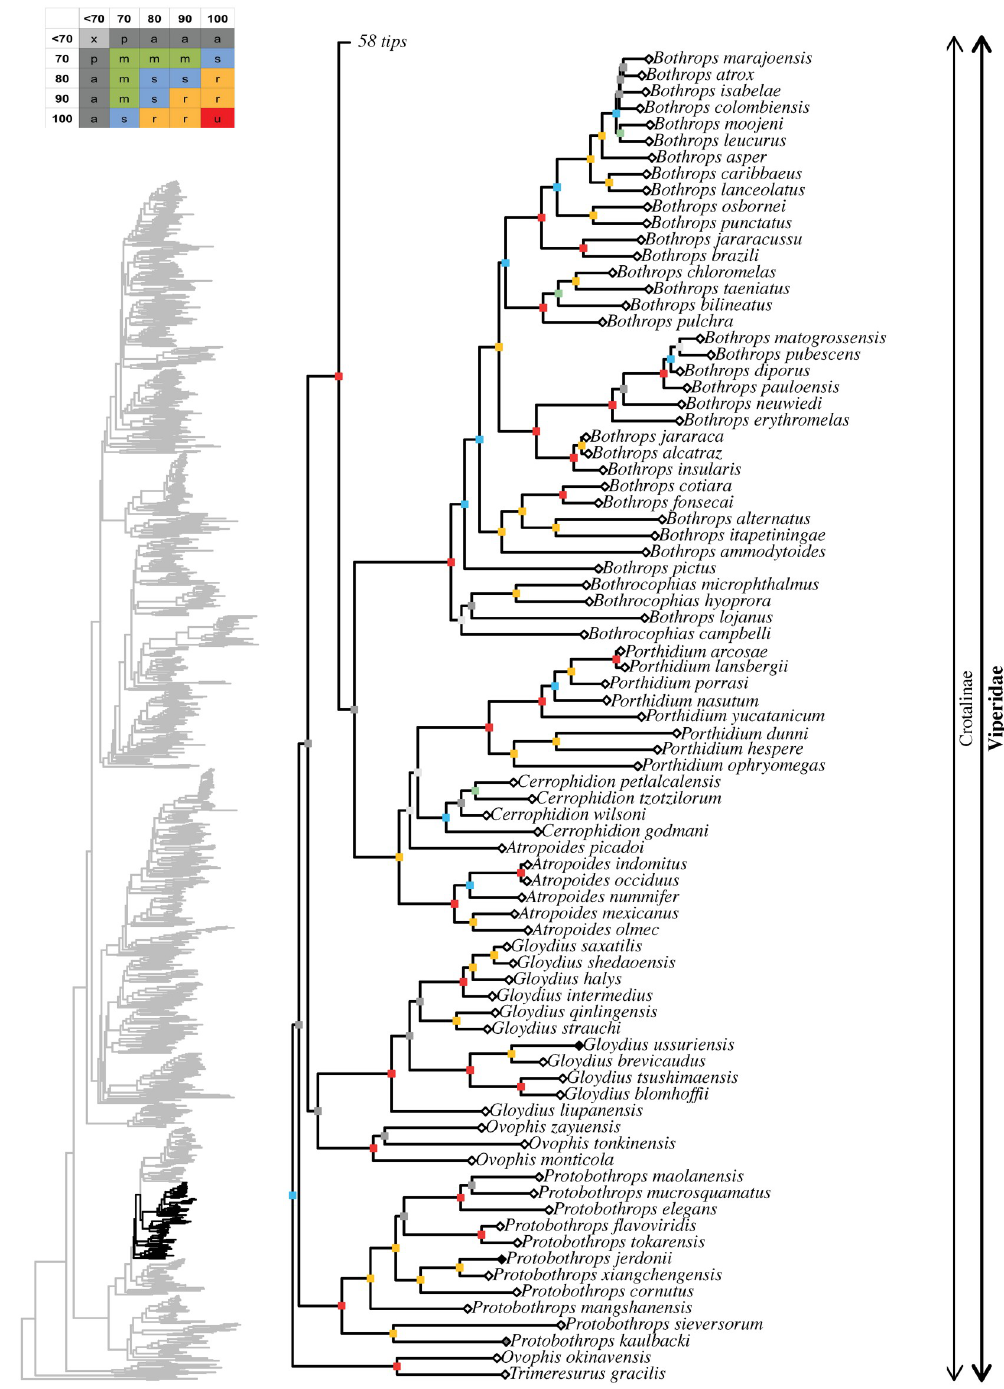
Fig 8. Maximum likelihood species-level phylogeny of Colubroides (continued). Family Viperidae, subfamily